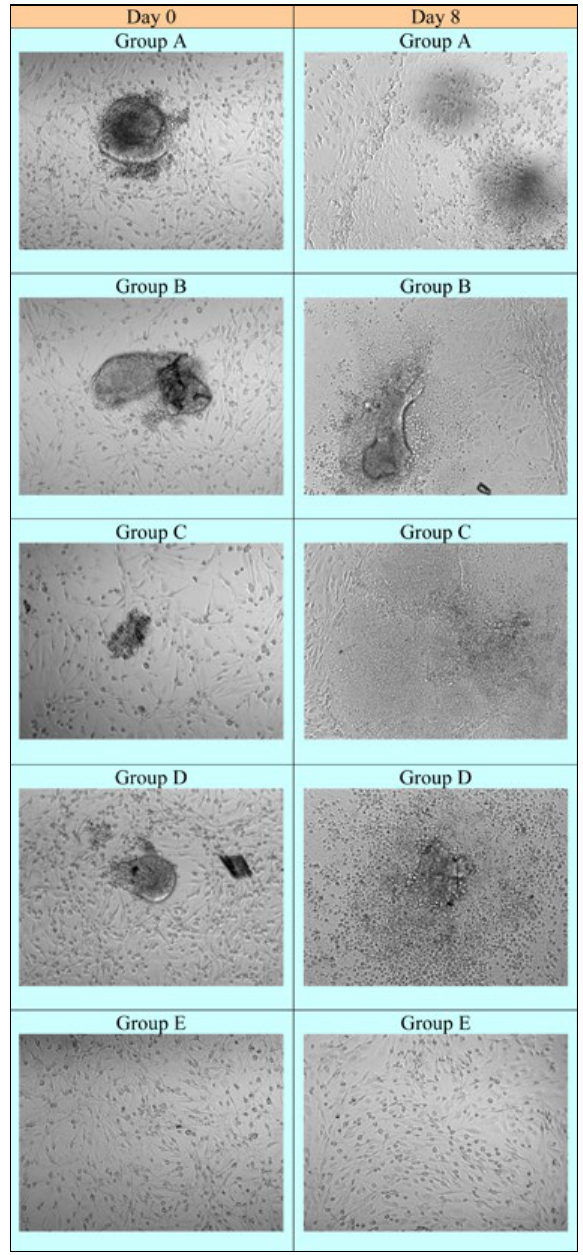
Figure 1. Photographs of human embryonic stem cell colonies using bright field (BF) light microscopy, at ×100 magnification (Olympus TM IX81, Japan). Left side Day 0, Right side Day